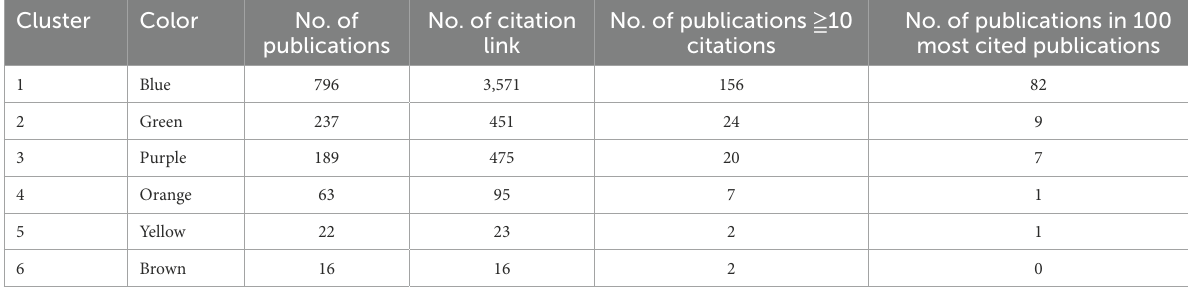
TABLE 1 Six clusters and citation